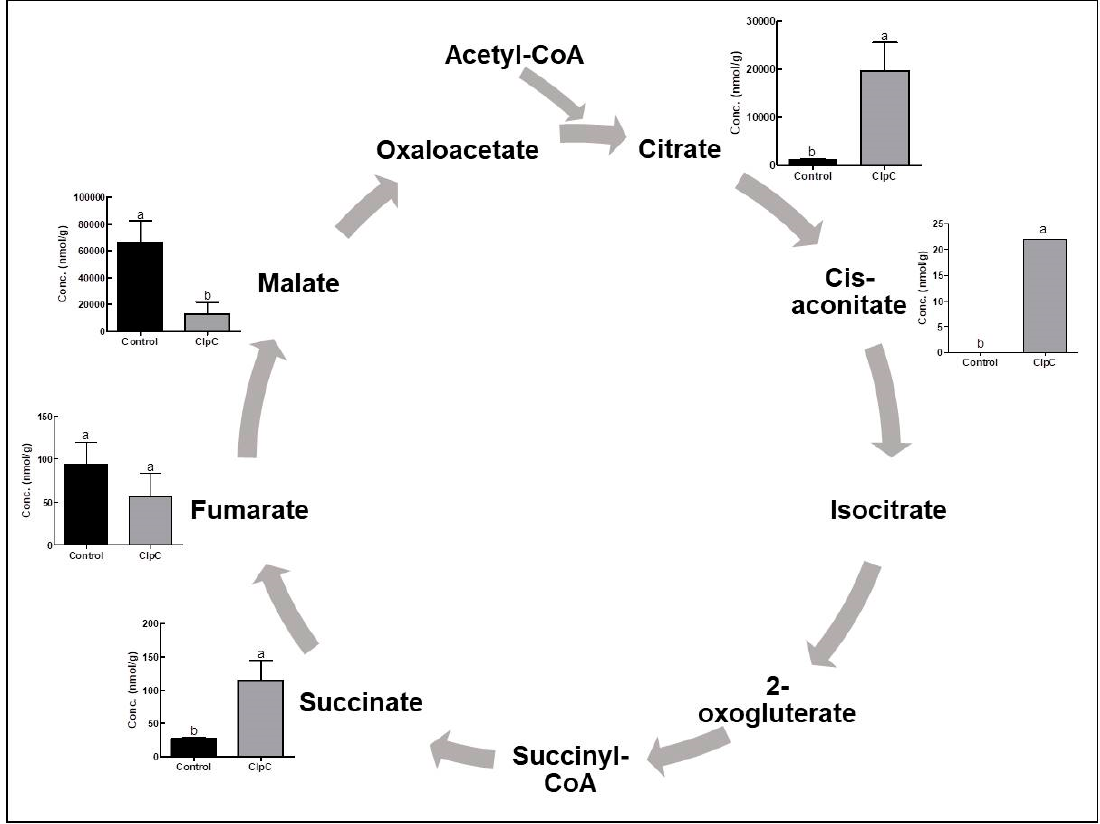
Figure 3. Changes in TCA cycle-related metabolite contents with co-suppression of NbClpC1 / C2. ClpC: NbClpC1 / C2 co-suppressed N. benthamiana . The error bars indicate the SD of triplicate samples. The di ff erent letters on the bars indicate statistically significant di ff erences between groups ( p < 0.05). 2.4. E ff ects of NbClpC1 / C2 Co-Suppression on the Levels of Intermediate Metabolites of the